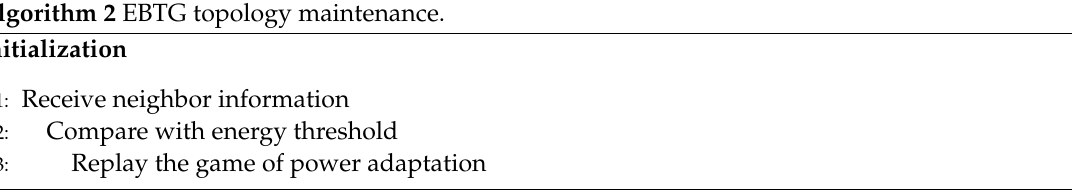
Algorithm 2 EBTG topology